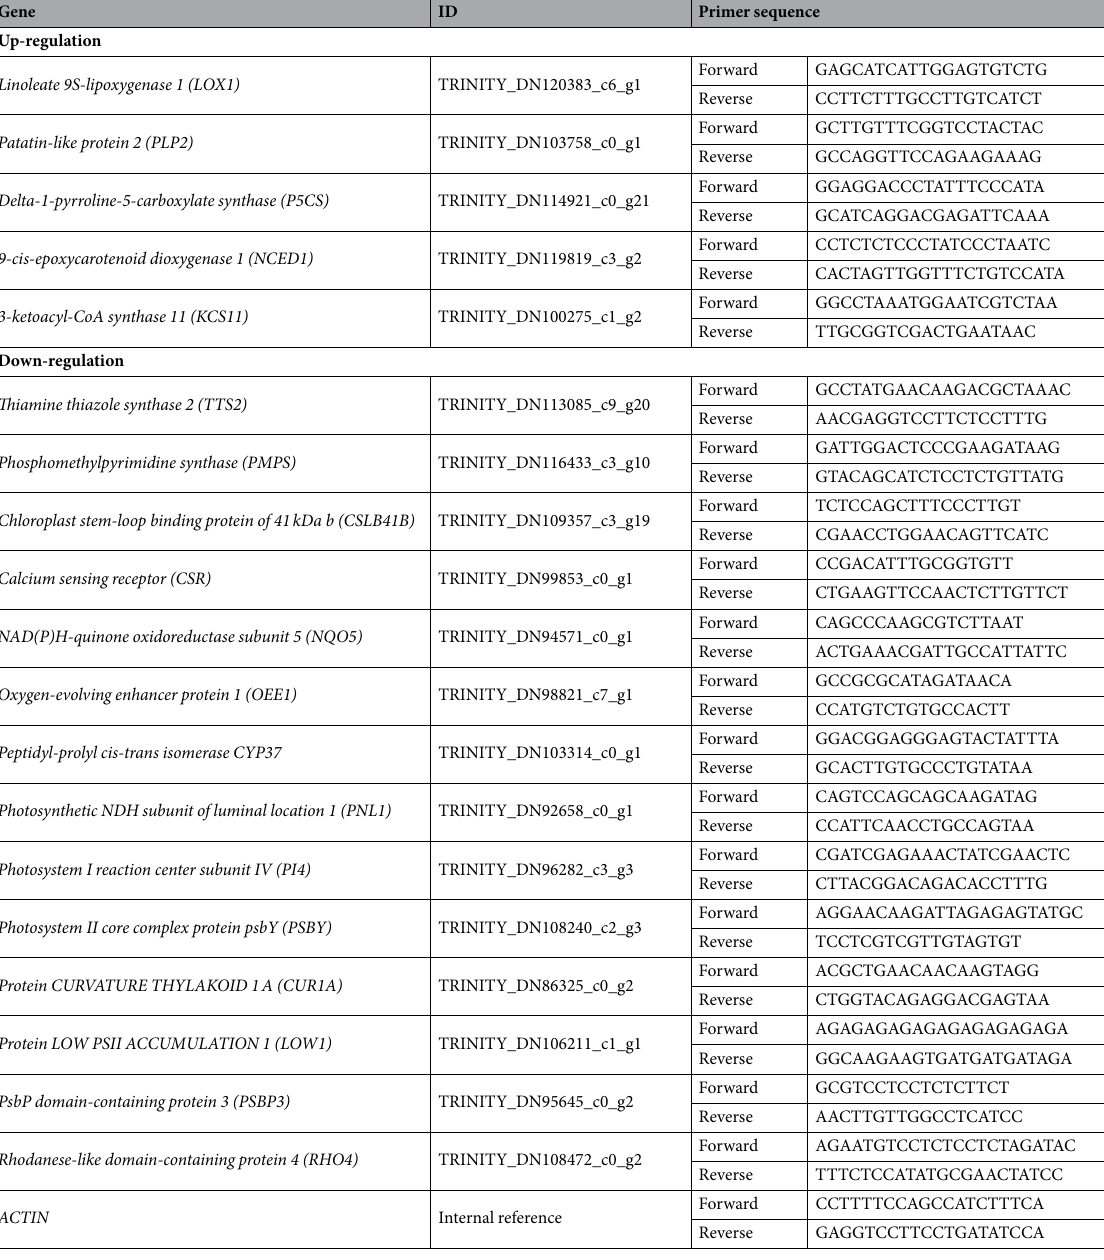
Table 4. Primer sequences of genes used in qRT-PCR. Gene names and transcript IDs are also